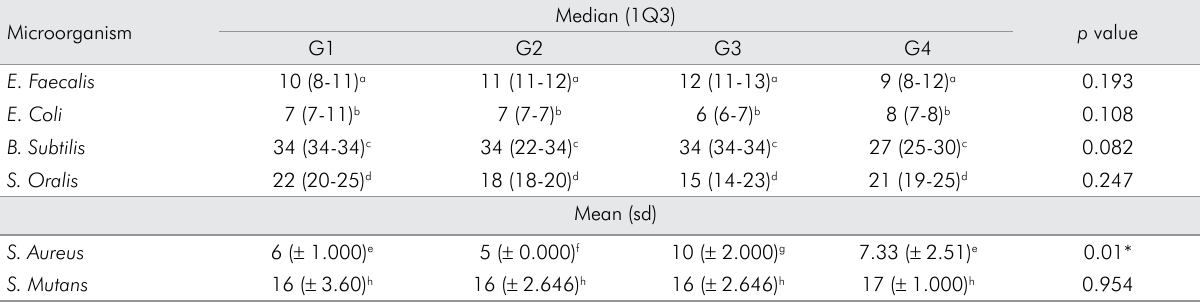
Different letters in rows indicate significant differences ( p ≤